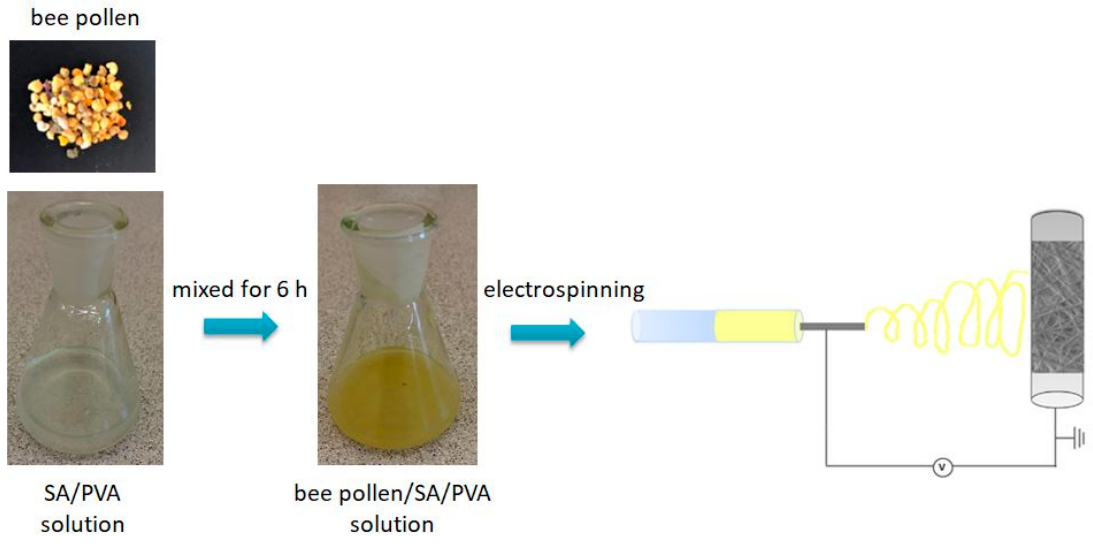
Figure 1. Scheme of the bee pollen-loaded SA/PVA electrospun nanofibrous mats fabrication by electrospinning.